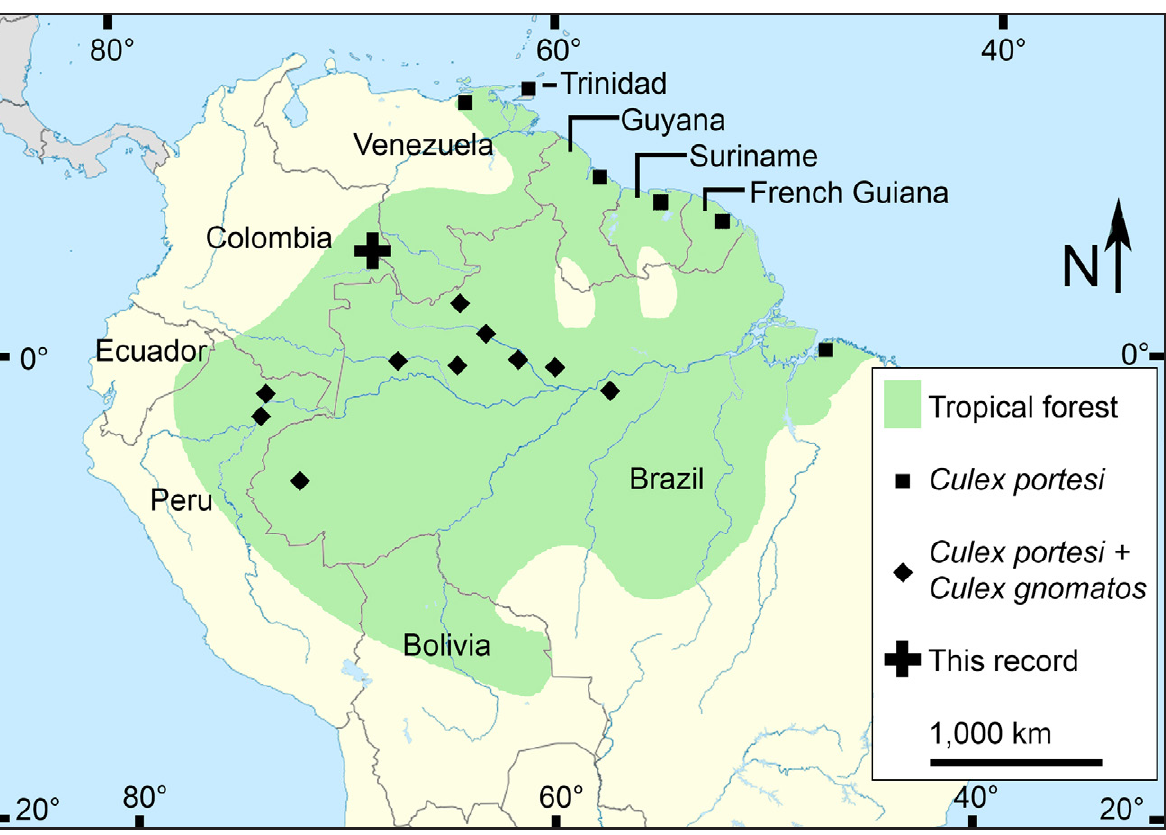
Figure 2. Map showing location of Spissipes section females in Guainía, Colombia. Base map attribution: Cephas, CC BY-SA 4.0,